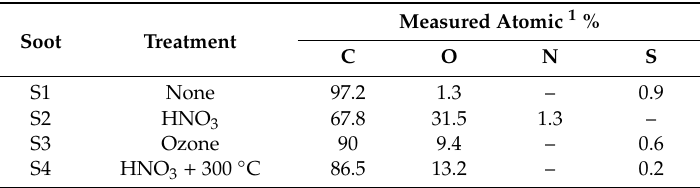
Table 1. Elemental content measured as atomic percent for samples S1–S4. S1: nascent soot, S2: nitric acid-treated soot, S3: ozone-treated soot, S4: nitric acid and heat-treated soot.